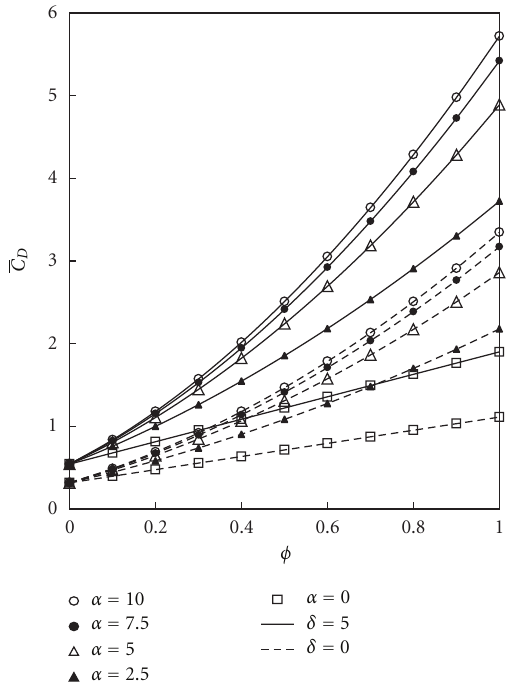
Figure 4: Variation of dynamic sti ff ness coe ffi cient with respect to Langevin parameter α for film thickness ratio r = 2 and di ff erent values of φ